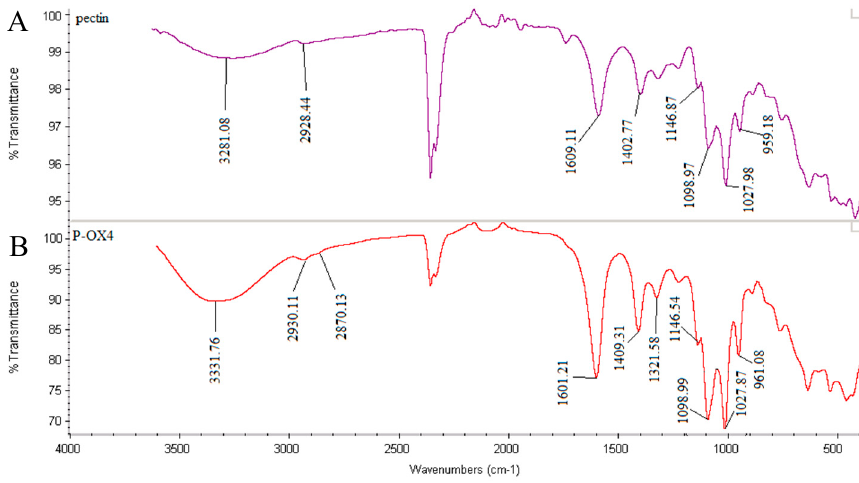
Figure 2. Fourier transform infrared (FT-IR) spectra of: ( A ) pectin, and ( B ) P-OX4.